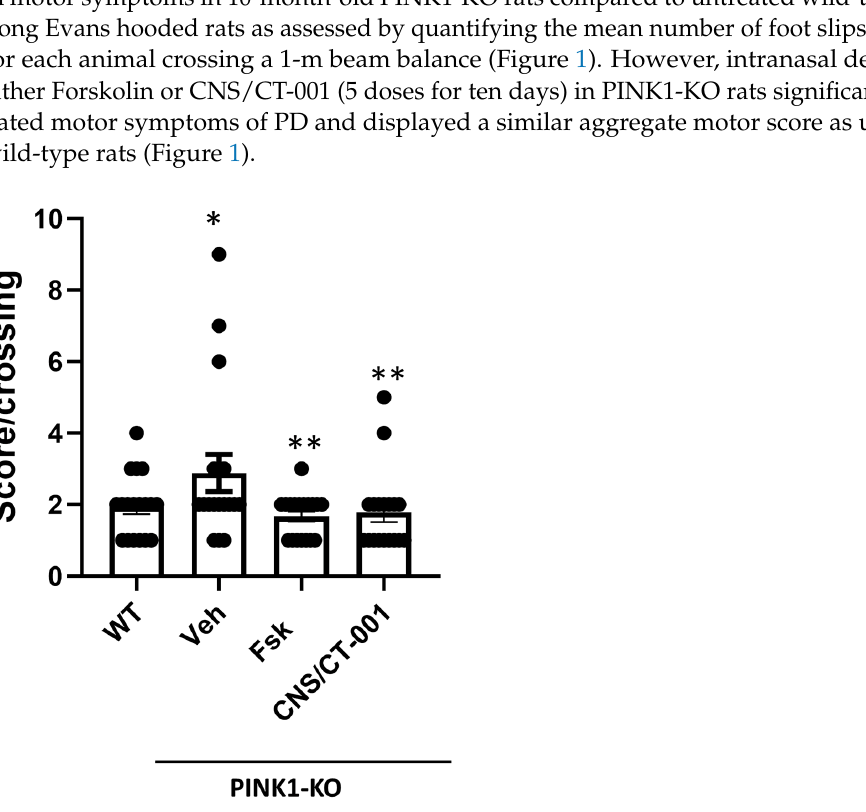
Figure 1. Intranasal delivery of Forskolin or CNS/CT-001 reverses motor symptoms PINK1-KO rats. Unbiased assessment of motor coordination as determined by using a beam balance in wild-type (WT) and PINK1-KO rats that were left untreated (baseline) or were intranasally treated with vehicle (Veh) control, Forskolin (Fsk), or with CNS/CT-001 (10 days for five doses). In brief, the data shows that either intranasal administration of Forskolin or CNS/CT-001 efficiently abrogated the loss of motor coordination in symptomatic PINK1-KO rats to a similar extent as in untreated or WT rats. Mean ± SEM. n = 12–25 animals per group, *: p ≤ 0.05, Kruskal-Wallis test with Bonferroni correction. *: p < 0.05 vs. WT group; **: p < 0.05 vs. PINK1-KO/Veh group. Each circle indicates an individual animal plotted in the graph.